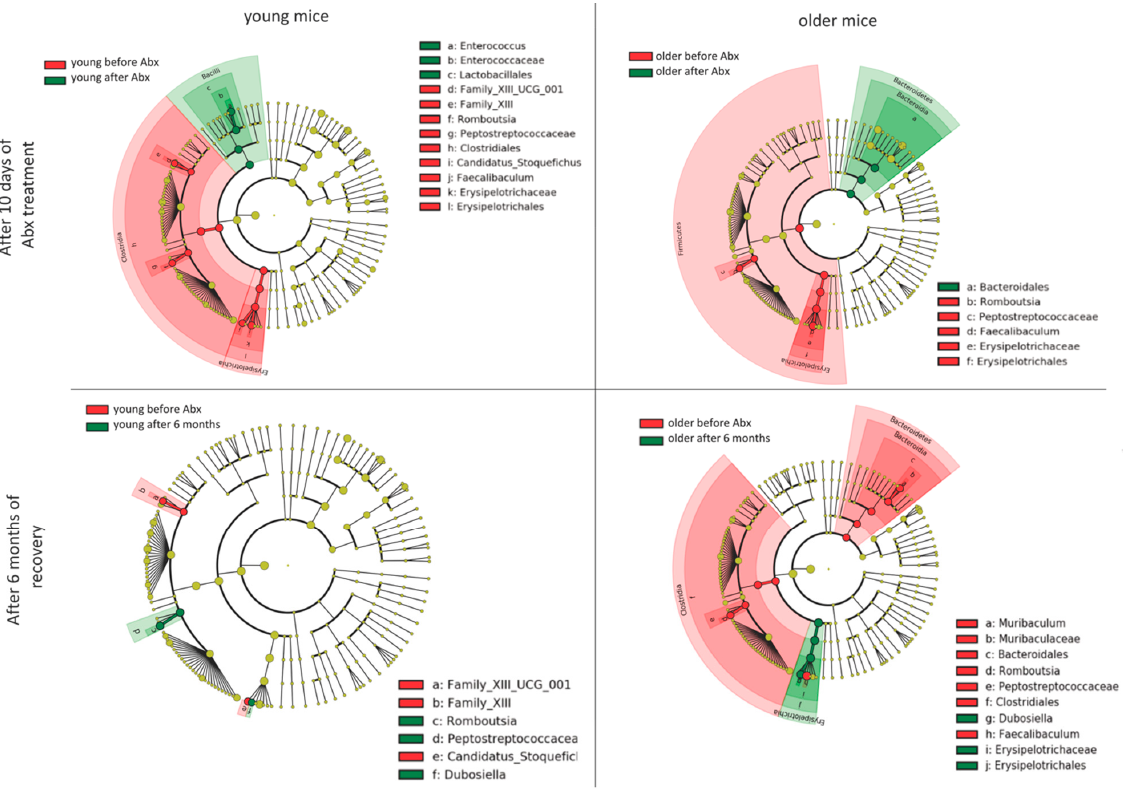
Figure 5. Linear discriminant analysis (LDA) effect size (LEfSe) of differentially abundant bacterial taxa between young (left panels) and older mice (right panels) after 10 days of Abx treatment (upper panels) or after 6 months of recovery (lower panels). Cladograms represent phylogenetic branches of taxa significantly more abundant in the two analyzed groups.